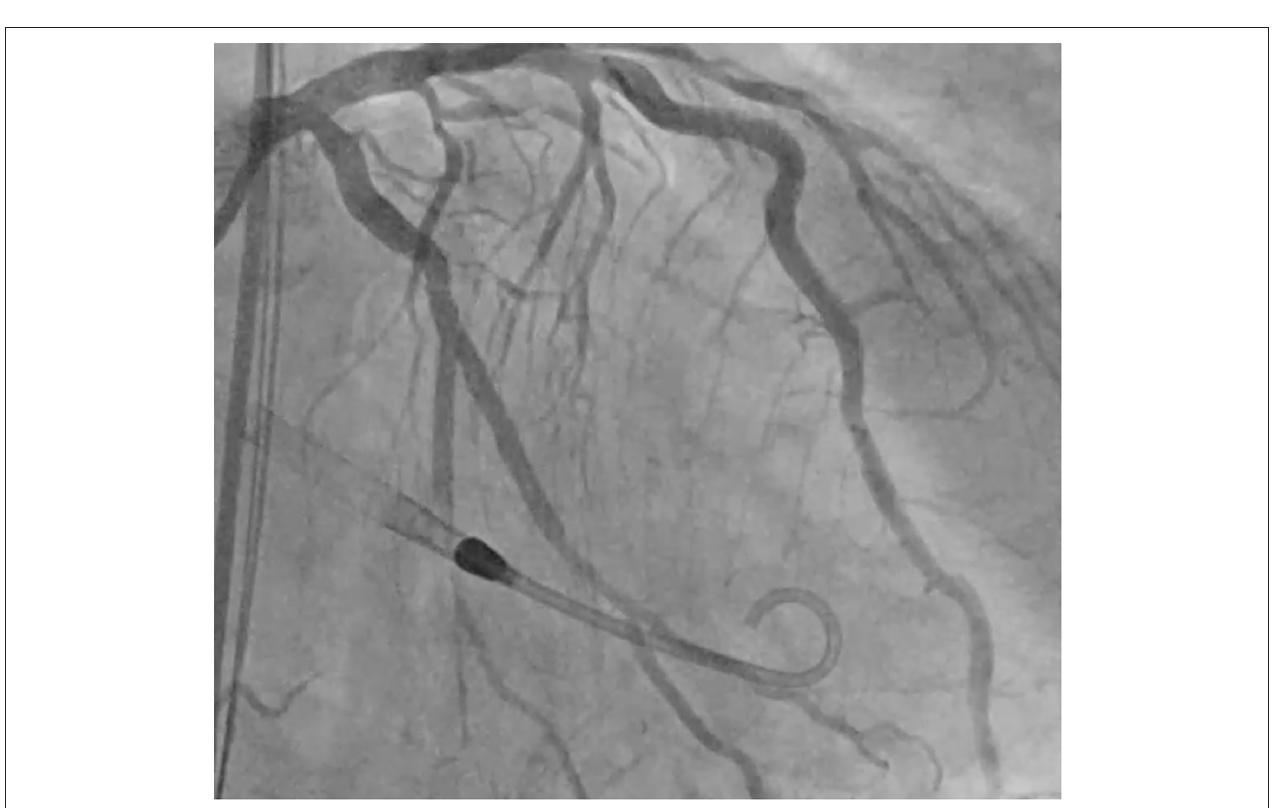
FIGURE 3 | Left circumflex coronary artery after PCI. Final result after implantation of two drug-eluting stents using the T-stent